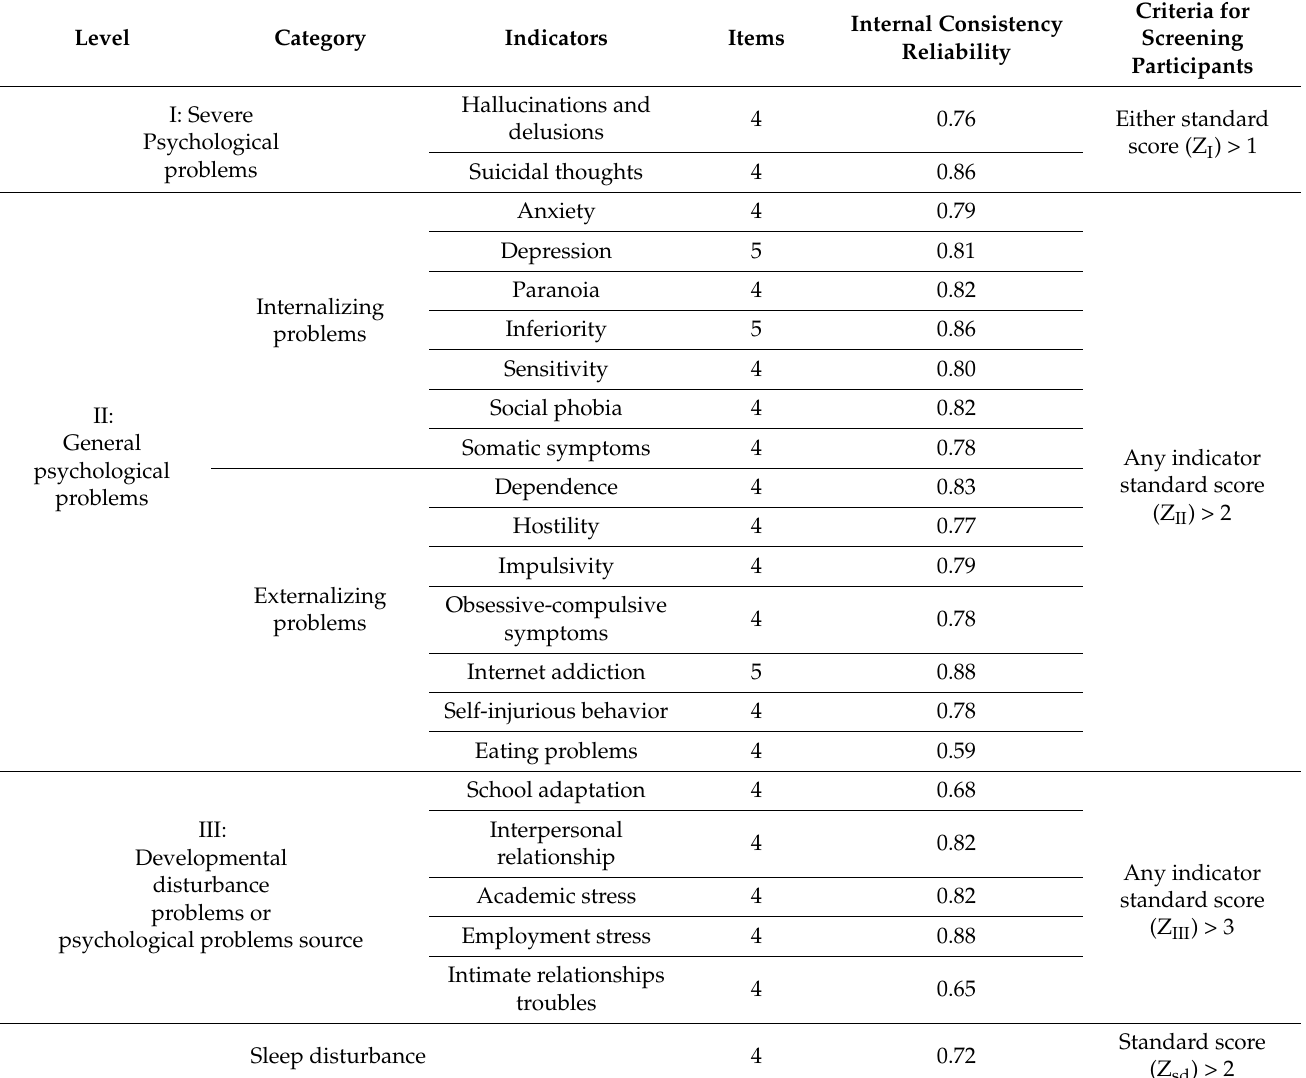
Table 1. Chinese college students’ mental health screening scale and